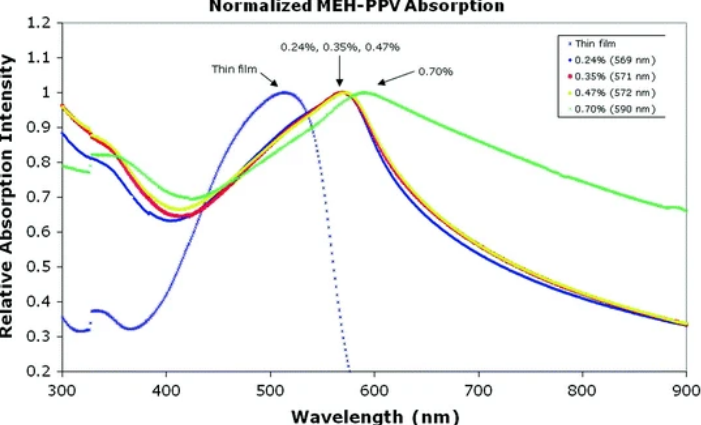
Figure 24. MEH-PPV absorptions of 0.24, 0.35, 0.45, and 0.7% concentrations in chloroform. All curves were normalized to their maximum value. Reproduced from [161] under a Creative Commons Attribution License.